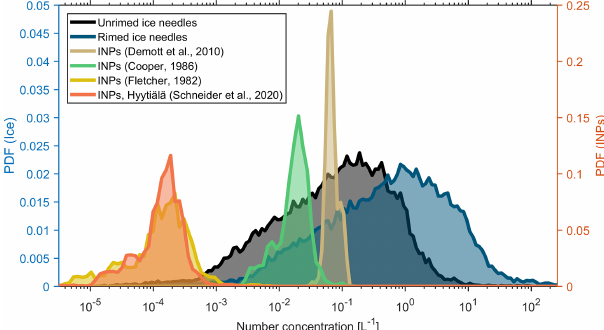
Figure 12. Probability density function (PDF) of estimated colum- nar ice (left) and INP (right) concentrations in shallow single-layer clouds. INPs: ice-nucleating